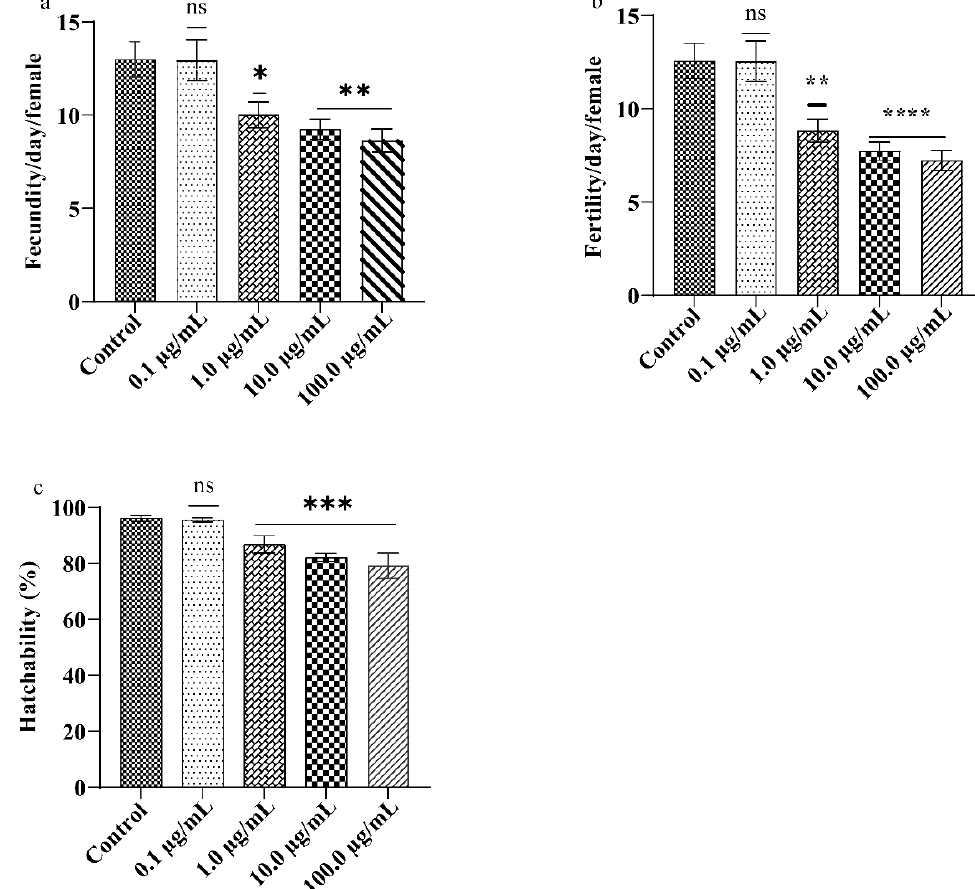
Figure 3. Reproductive assay: ( a ) fecundity, ( b ) fertility, ( c ) percentage hatchability. Significance is ascribed as ns (non ‐ significant), * p < 0.05, ** p < 0.01, *** p < 0.001 and **** p < 0.0001 with respect to control.